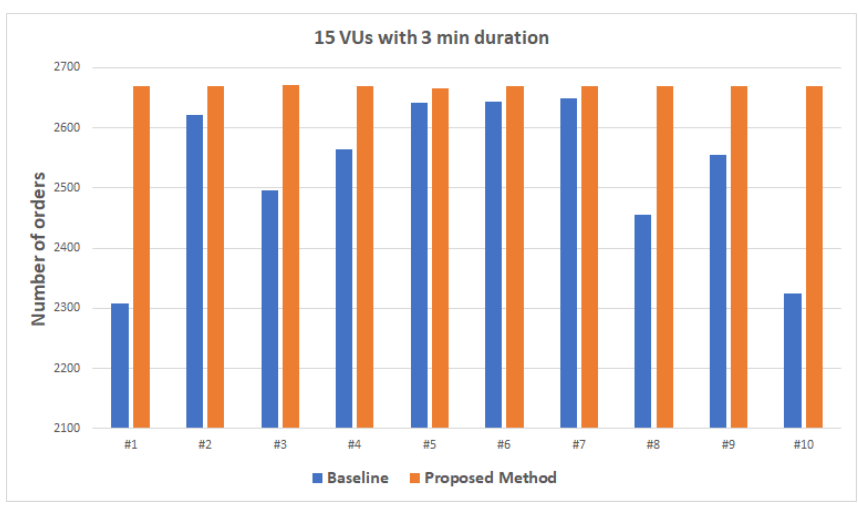
Figure 20. Load Testing—10 virtual users with 3 min duration.